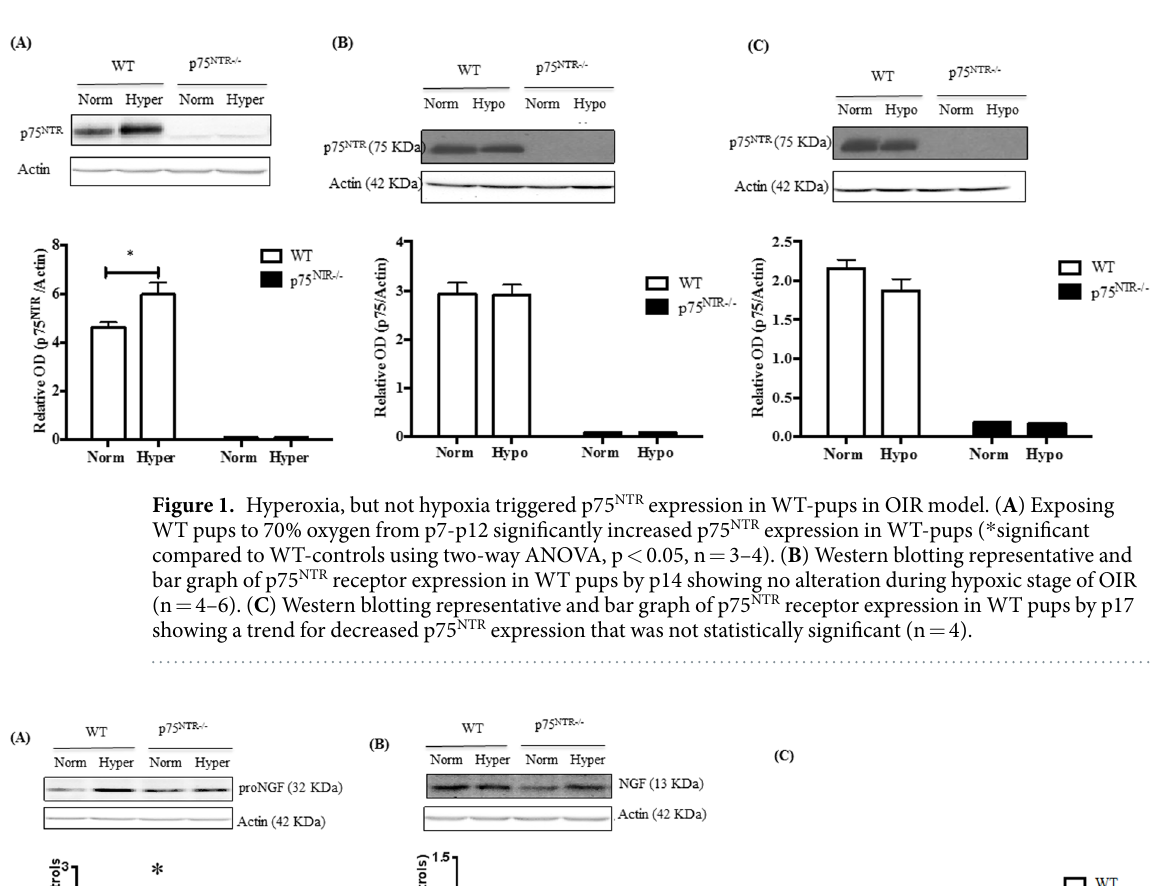
RNV by 42% compared to WT-pups (Fig. 5B,C). More importantly, Deletion of p75 NTR stimulated reparative angiogenesis as indicated by growth of capillaries toward the central retina and decreasing central avascular area by ~32% compared to WT-pups during hypoxic stage of OIR model (Fig. 5B,D). Hypoxia triggered VEGF expression and VEGFR2 activation in both WT and p75 NTR knock- out. Expression of vascular endothelial growth factor (VEGF), a well-studied angiogenic factor in OIR model is triggered by hypoxia and correlates with RNV 29 . Therefore, we investigated impact of deleting p75 NTR on VEGF level and its signal. At p14, hypoxia resulted in significant 2.2-fold increase in VEGF mRNA expression in WT pups (Supplementary Fig. 2A) and 1.53-fold increase in VEGF protein expression in retinas of WT pups as compared to normoxic controls (Fig. 6A). Deletion of p75 NTR receptor tended to alter but did not reach statistical significance the basal expression of VEGF mRNA or protein in normoxia. Yet upon hypoxia exposure, retinas from p75 NTR − / − pups showed tendency of increased mRNA expression of VEGF that was not statistically significant (Supplementary Fig. 2A), and significant increase by 1.6-fold in VEGF protein as compared to normoxic controls (Fig. 6A). Next, we examined activation of VEGF receptor-2 (VEGFR2) known to mediate angiogenic signal. Exposure to relative